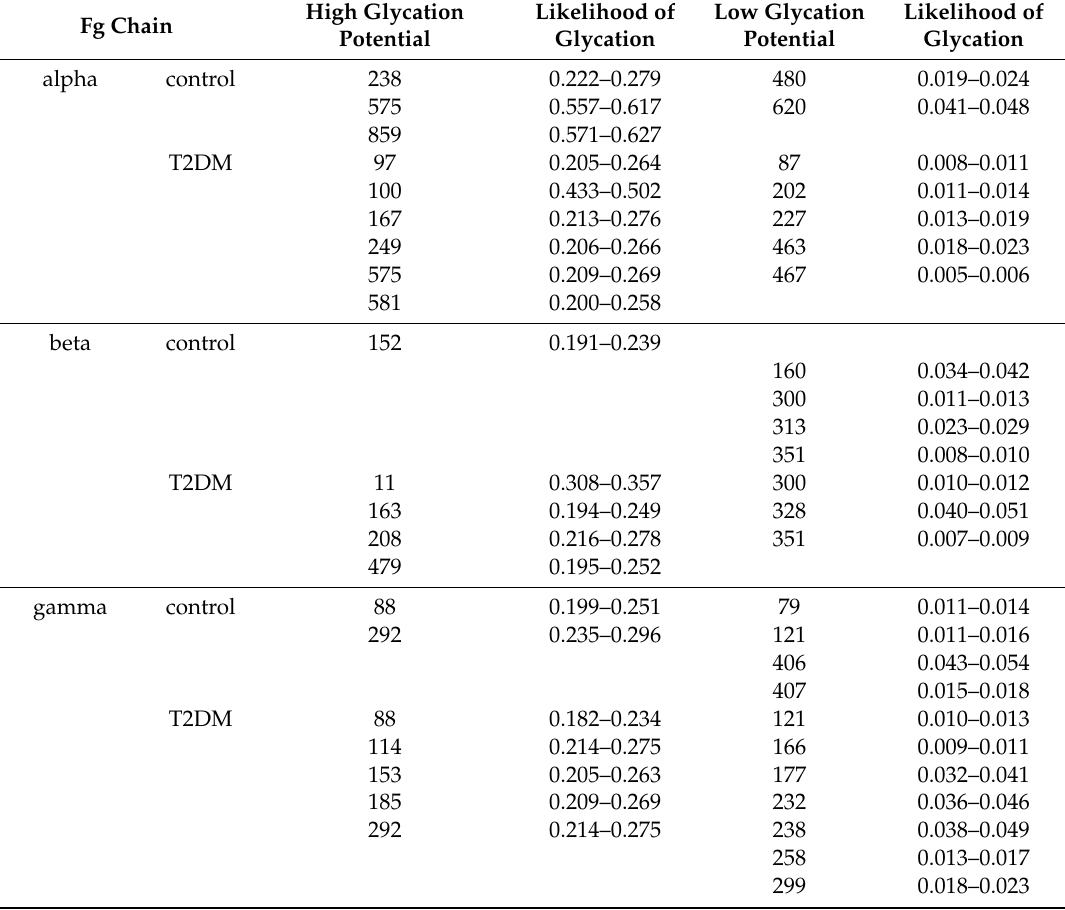
Table 4. The relevance of fructosyl-lysine residues in α , β and γ chains of fibrinogen from examined T2DM patients and control subjects to the positions of the NetGlycate-predicted glycation sites of high or low glycation